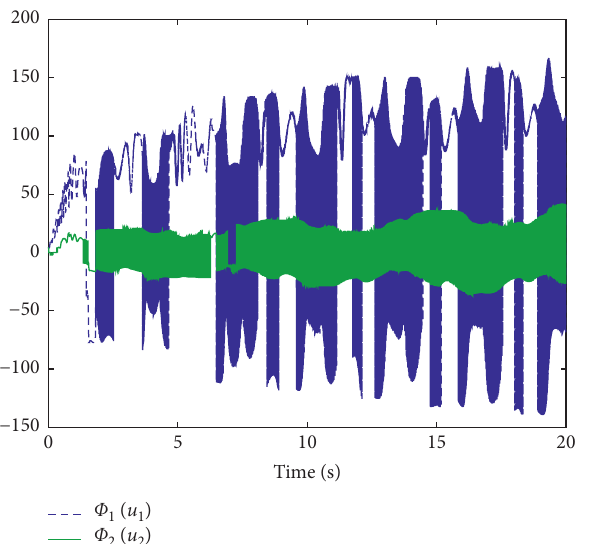
Figure 4: Control input function for Φ